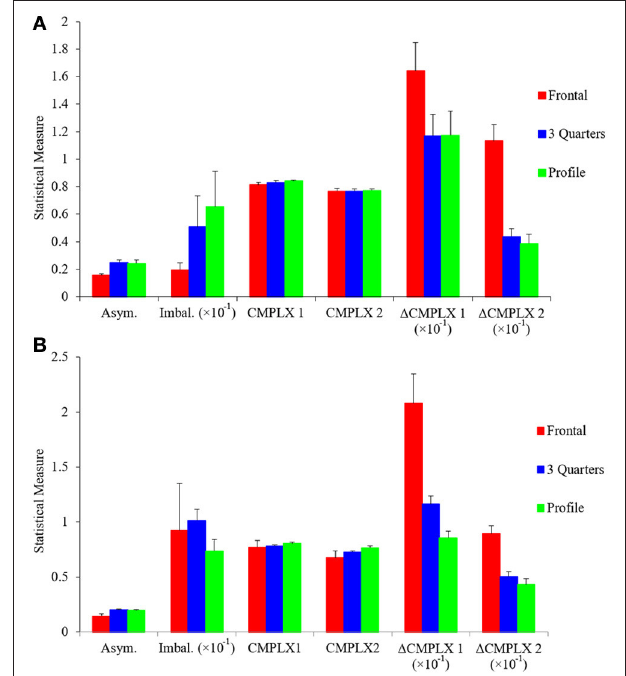
FIGURE 6 | Different measures of asymmetry, imbalance, and complexity as a function of pose. (A) Control photographs and (B) portrait paintings at frontal (0 ◦ ), 3 quarters (45 ◦ ), and profile (90 ◦ ) poses. Horizontal-axis categories are Asym. (Index of Asymmetry—Equation 1), Imbal. (Index of Imbalance—Equation 4), CMPLX1 (Complexity of Order 1—Equation 11), CMPLX2 (Median Complexity of Order 2—defined in Figure 1 from Equation 12), 1 CMPLX1 ( 1 Complexity—defined in Figure 1 from Equation 12), and 1 CMPLX2 (same as 1 Complexity but starting from the Median Complexity of Order 2 instead of Complexity of Order 1). These statistical measures are shown as means and standard errors. Results were largely similar for both control photographs and for portrait paintings. Symmetry was lowest in frontal poses, with no difference between 45 ◦ and profile poses. Complexity of Order 1 and Median Complexity of Order 2 were similar for all three poses. Higher 1 -complexity values meant a greater loss in complexity, thus frontal poses were the least complex. The only difference between control photographs and portrait paintings was in respect to balance. There was lower balance in the frontal poses in the former but not the